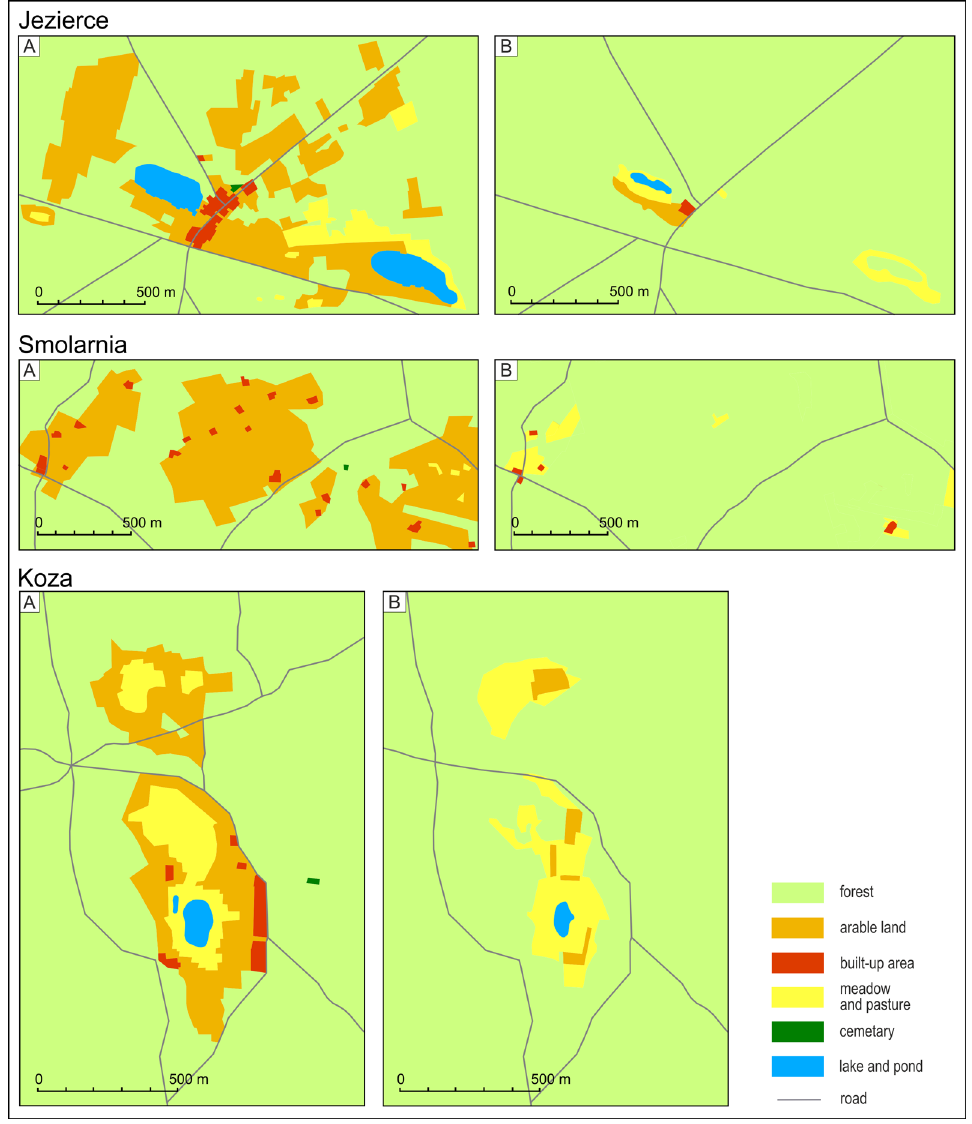
Fig. 4. Changes in land use structure in the villages of Jezierce, Smolarnia and Koza: A –